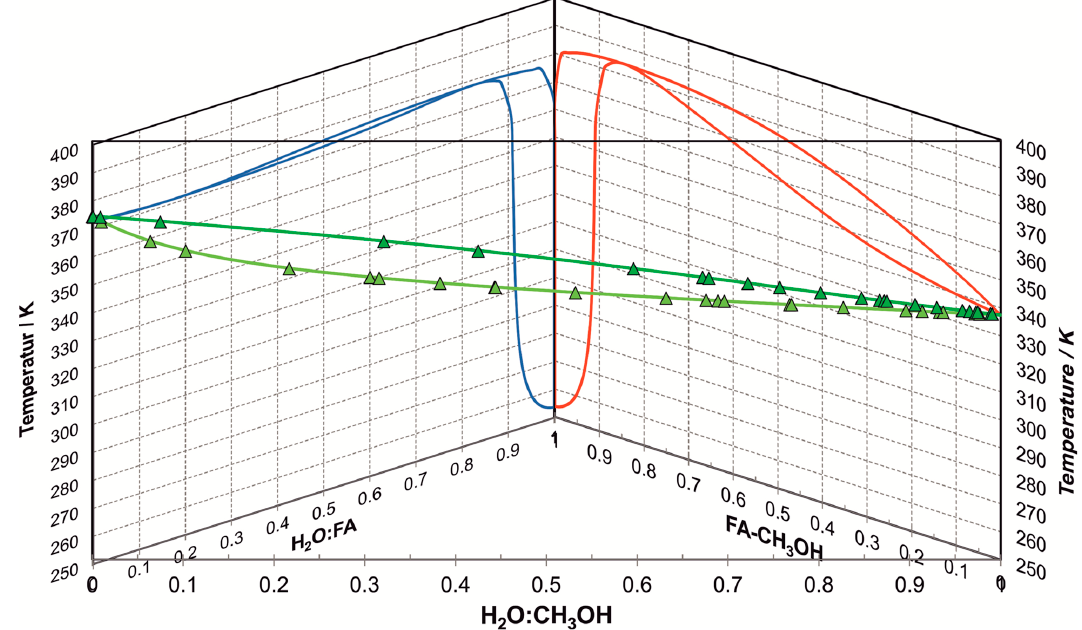
Figure A3. Prism illustration of temperature-dependet binary diagrams of the system W/MeOH/FA.